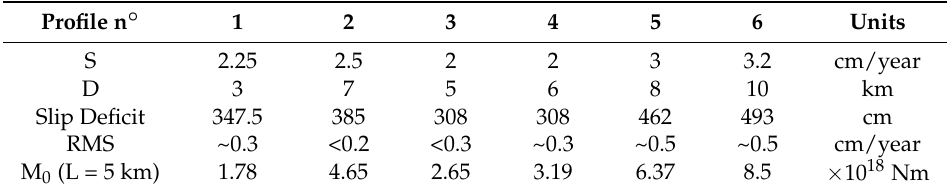
Table 1. Presentation of the values S and D, extracted from the adjustment of the arctangent function for the ground surface velocity. The deficit slip, the RMS corresponding to the chosen solution as well as the equivalent seismic moment per 5 km of fault length determined from each pair (S, D) for each profile, are presented